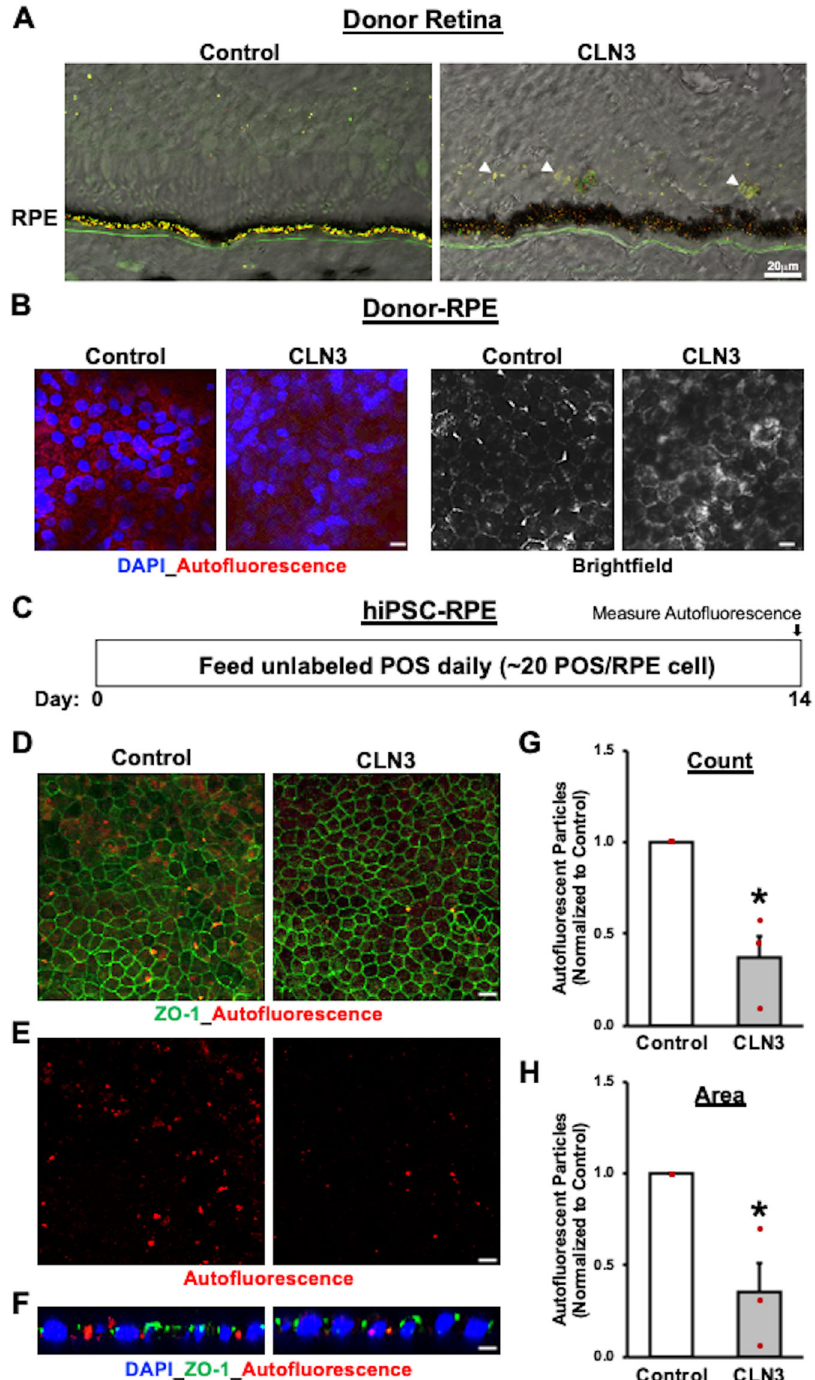
disease hiPSC-RPE cells compared to control hiPSC-RPE cells (Fig. 6C, D). In contrast, no difference in microvilli width (Fig. 6C, E) and length (Fig. 6C, F) was seen between control and CLN3